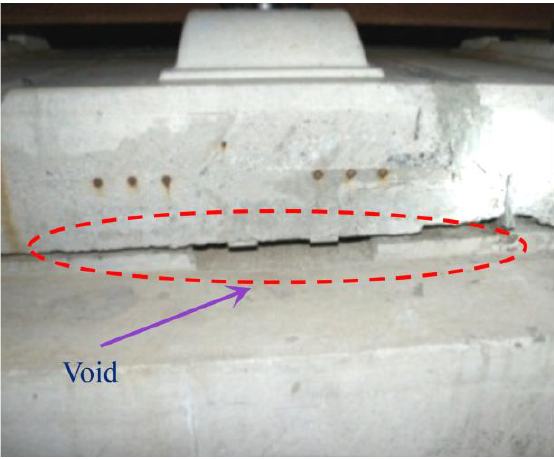
Figure 1. The void in the filling layer.